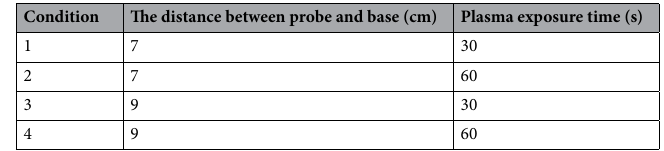
Table 8. Plasma treatment